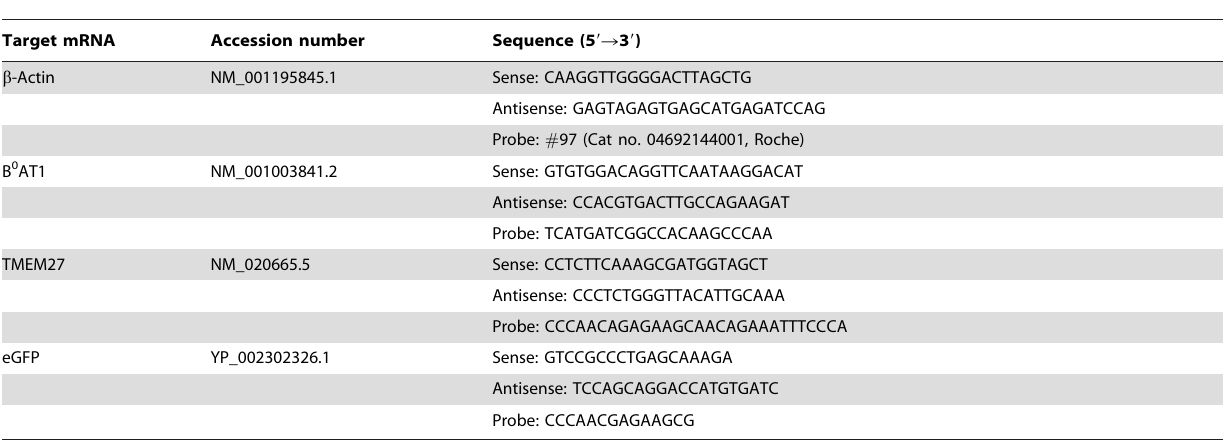
Table 2. List of primers and probes used for quantitative real-time PCR.